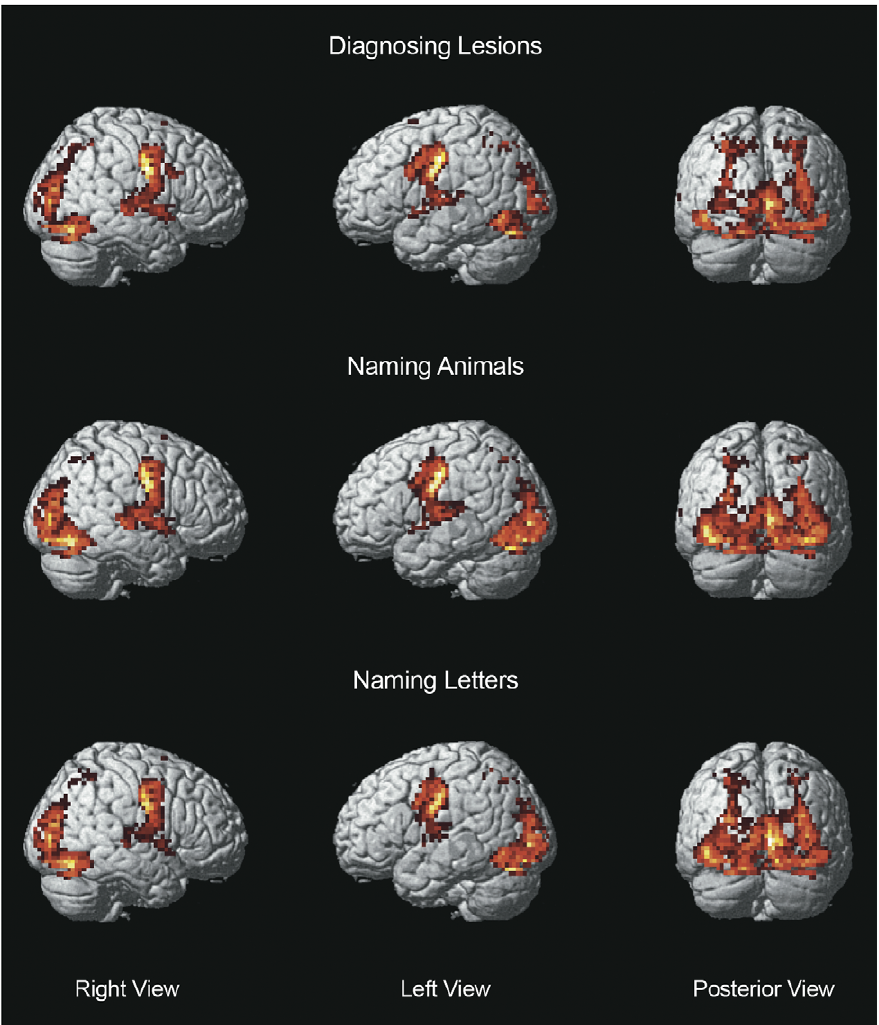
Figure 2. Cortical activations while diagnosing lesions and naming animals and letters versus control baseline *. *family wise error rate corrected p , 0.05. Statistical parametric maps rendered on an International Consortium of Brain Mapping individual